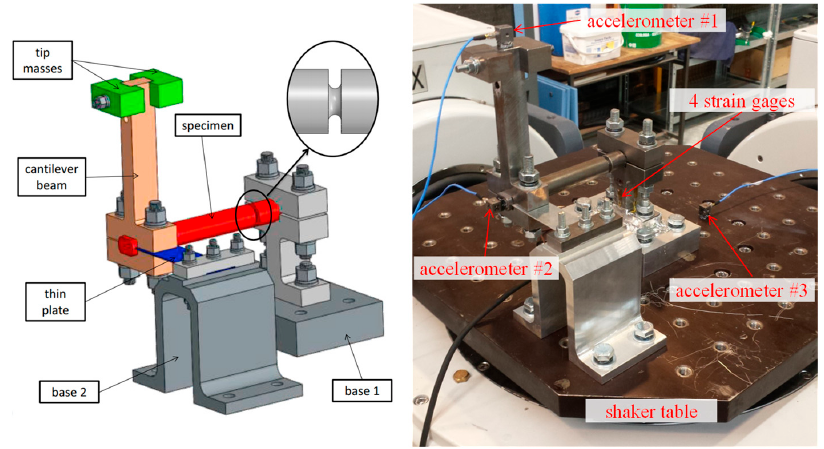
Figure 8. Testing system composed of a cylindrical specimen with eccentric tip masses, and excited by vertical and/or horizontal base accelerations (adapted with permission from ref. [19]. Copyright 2018 Elsevier).